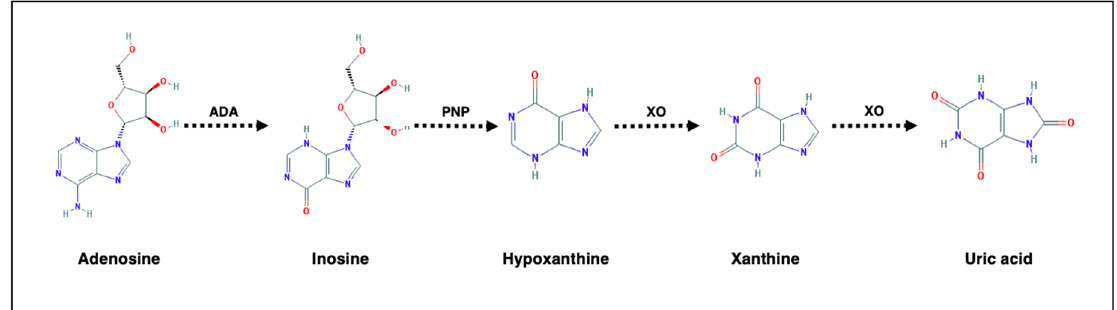
Figure 1. Adenosine metabolism. ADA = adenosine deaminase; PNP = Purine nucleoside phosphorylase; XO = xanthine oxidase. Chemical formulae are retrieved from PubChem (https://pubchem.ncbi.nlm.nih.gov).